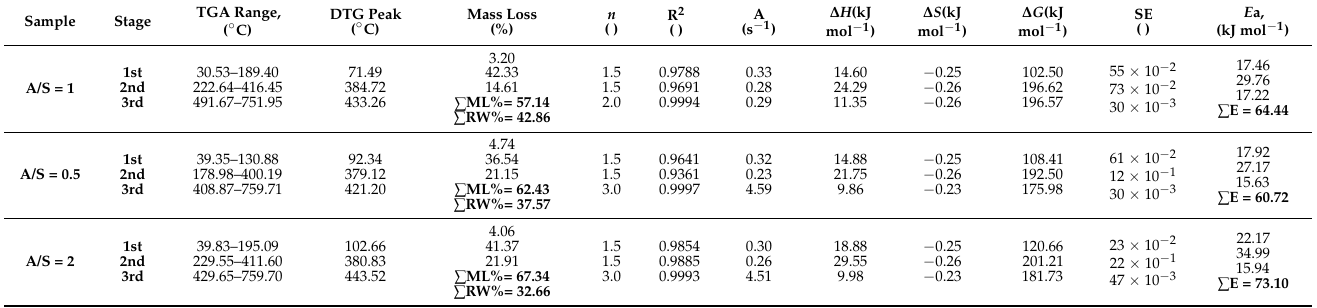
and 2.89%, respectively, and was assigned to moisture and/or residual water content.